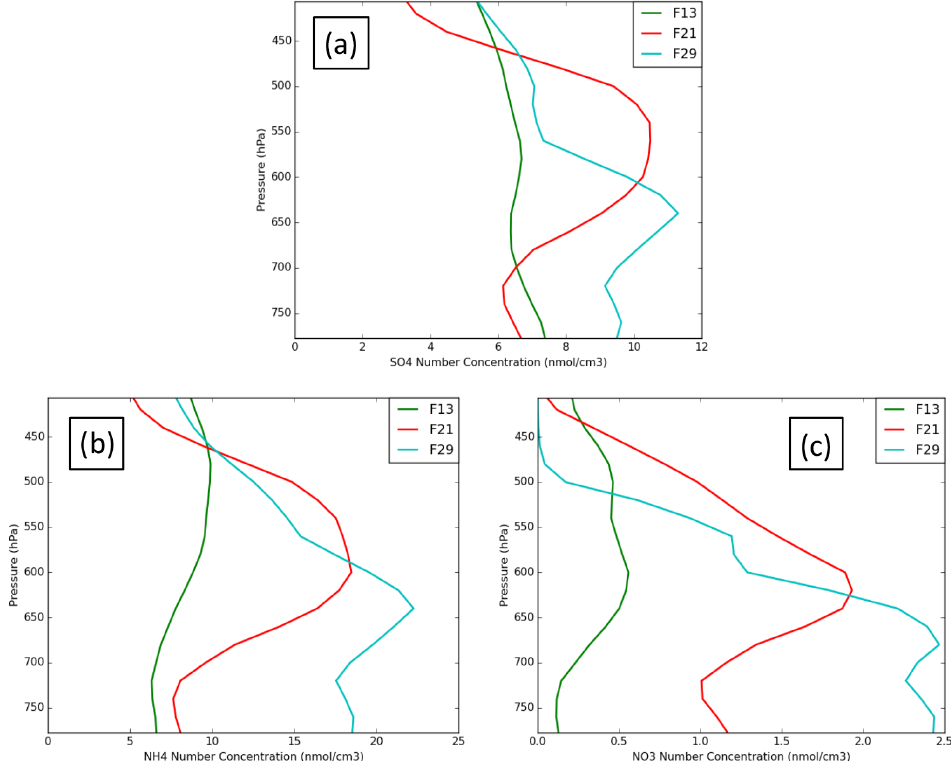
Figure 4. Vertical profiles of sulfate (a) , ammonium (b) and nitrate (c) molar aerosol concentration along flights F13 (green), F21 (red) and F29 (light